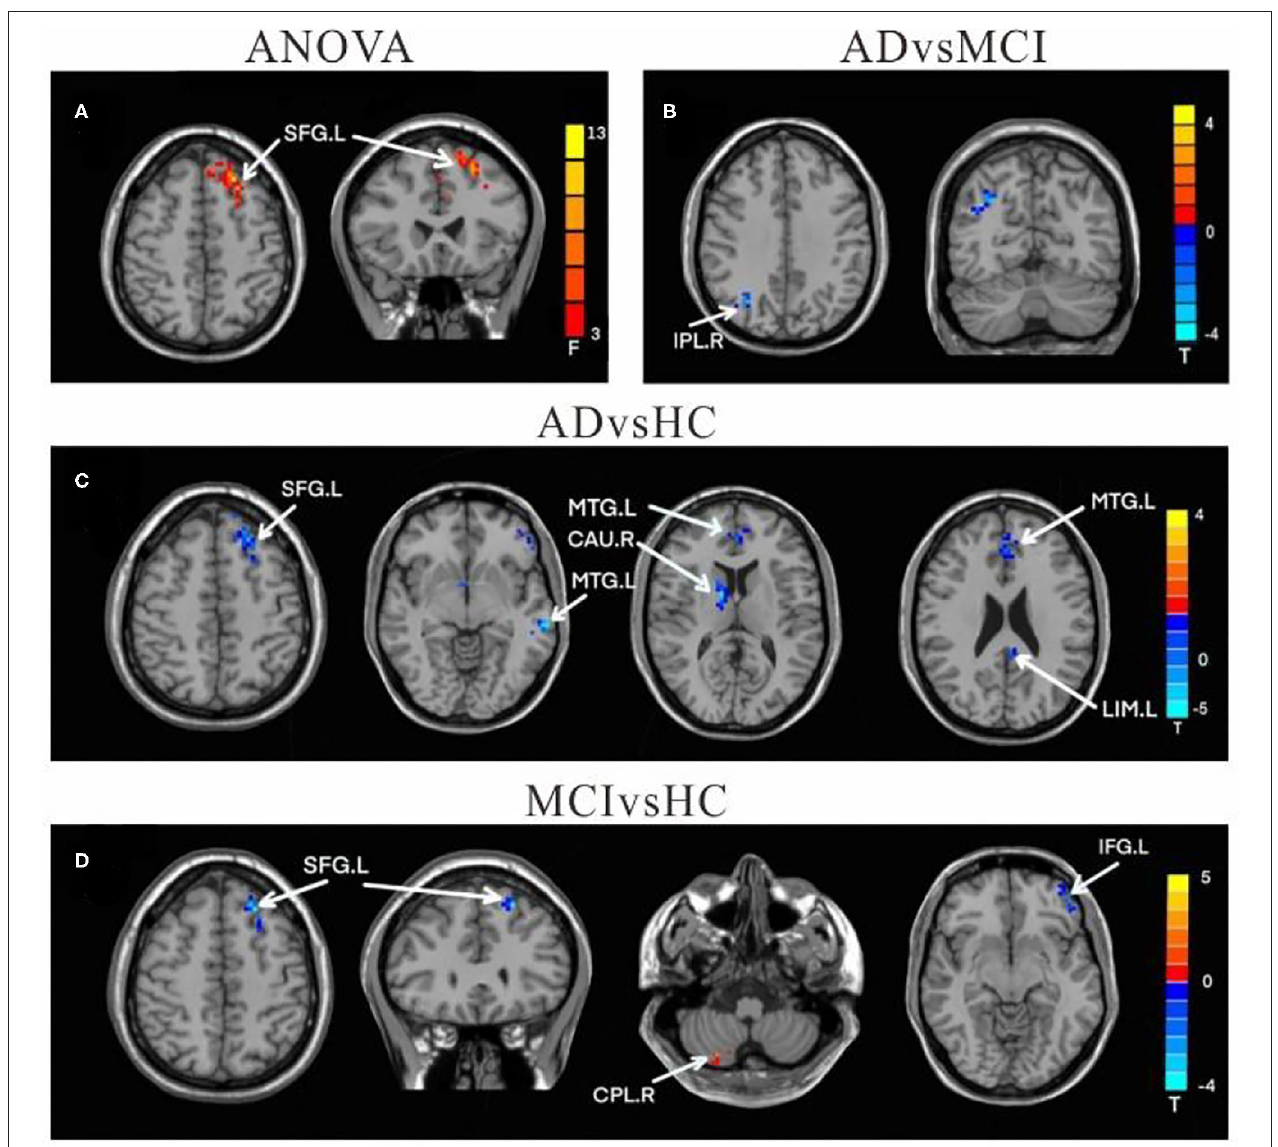
FIGURE 3 | Differences of FC values in the right cerebellum Crus II. (A) Brain regions showing significant differences in FC of the right cerebellum Crus II based on analysis of variance (ANOVA) analysis between HC, AD, and aMCI patients, p < 0.05, the cluster size > 100 voxels). (B–D) The results of post-hoc two-sample T -tests in voxel-wise analysis (Bonferroni corrected, cluster size ≥ 30 voxels, p < 0.05). AD, Alzheimer’s disease; aMCI, amnestic mild cognitive impairment; HC, healthy controls; SFG, superior frontal gyrus; IPL, inferior parietal lobe; MFG, Middle Frontal Gyrus; CAU, Caudate; LIM, limbic lobe; CPL, cerebellum posterior lobe; IFG, inferior frontal lobe; L, left; R,